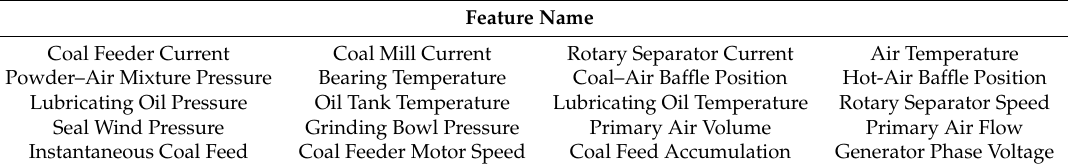
Table 1. The selected condition monitoring (CM)